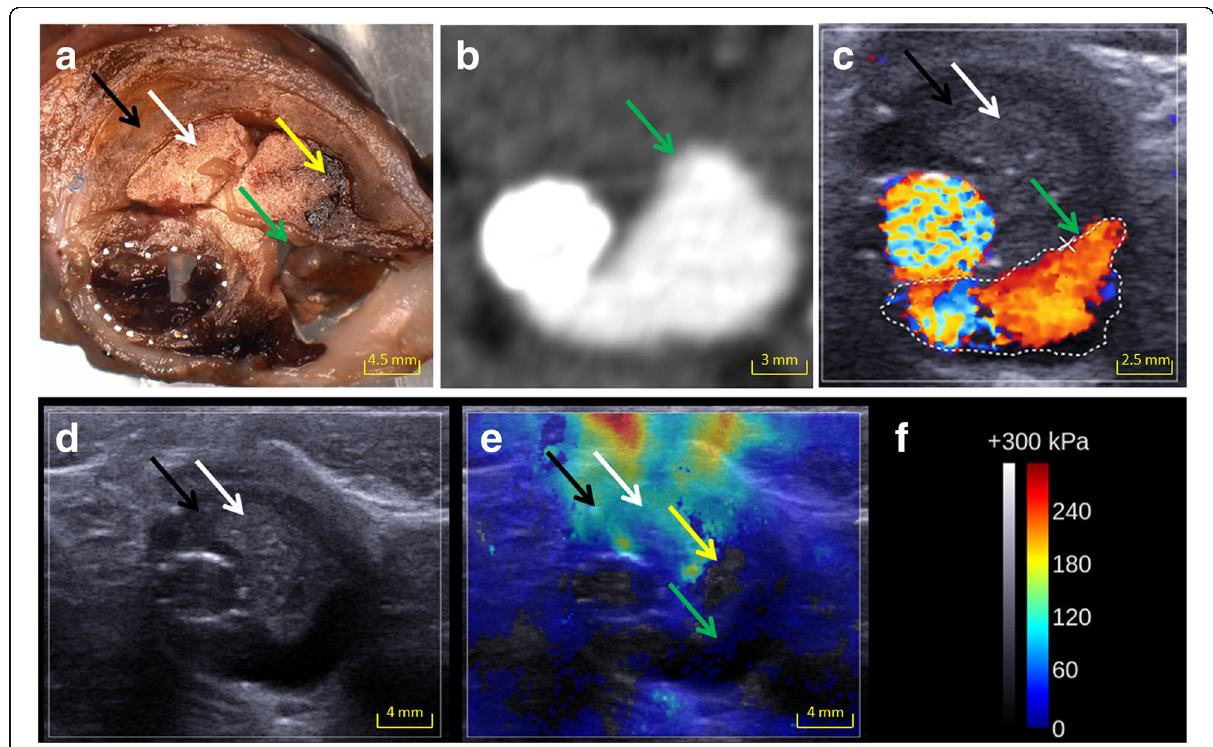
Fig. 1 Images from an aneurysm with endoleak ( green arrow ), chitosan ( white arrow ), less-organised chitosan ( yellow arrow ) and organised thrombus ( black arrow ). a Macroscopic cut showing the different regions of interest. b CT scan showing the endoleak. c Endoleak on DUS. d Areas filled with chitosan were slightly hyperechoic and areas with endoleak were anechoic on B-mode ultrasound. e Endoleak and less organised chitosan were visualised on SW. f Colour scale and Q-Box values for